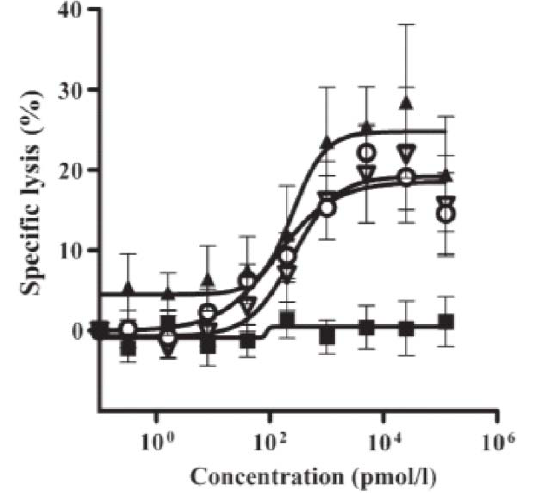
Figure 4. Lysis of primary AML cells by the dual-targeting sctb 123-ds16-33 and the mono-targeting control-molecules 123-ds16-123 and 33-ds16-33. Sctbs 123-ds16-33 (closed triangles), 123-ds16-123 (open circles) and 33-ds16-33 (open triangles) mediated dose-dependent ADCC of primary AML cells, whereas a control sctb (closed squares) failed to achieve this result. Target cells were primary cells from the peripheral blood of six different AML patients, diagnosed with AML of different subtypes. Data points represent mean percentage of specific lysis averaged over the six patients, obtained with isolated MNCs from one healthy donor per patient sample at an E:T ratio of 40:1. Specific lysis is total minus spontaneous lysis. From Kügler 2011 [11] with